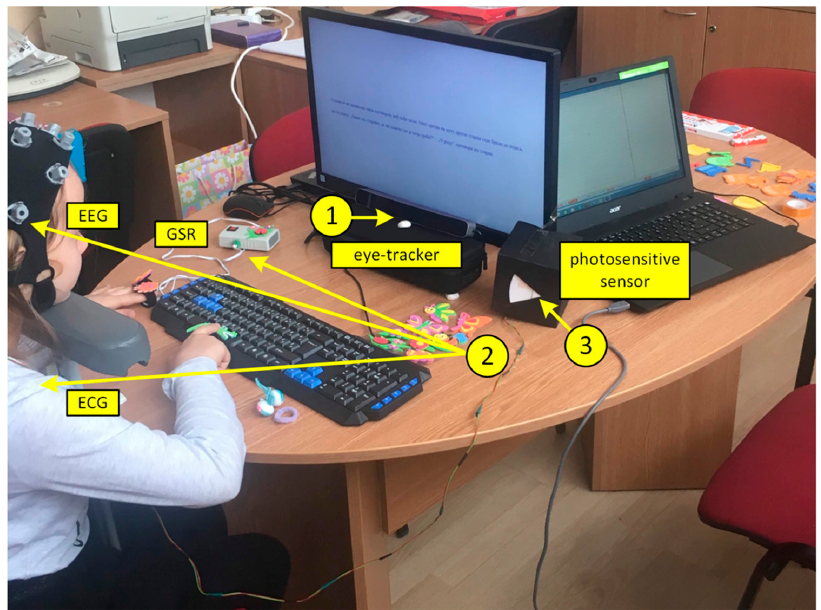
Figure 1. Experiment setup: ( 1 ) Eye-tracking system; ( 2 ) Portable multimodal EEG/ECG/EDA system; ( 3 ) Photosensitive sensor for synchronization of multimodal EEG/ECG/EDA system and eye-tracking system.